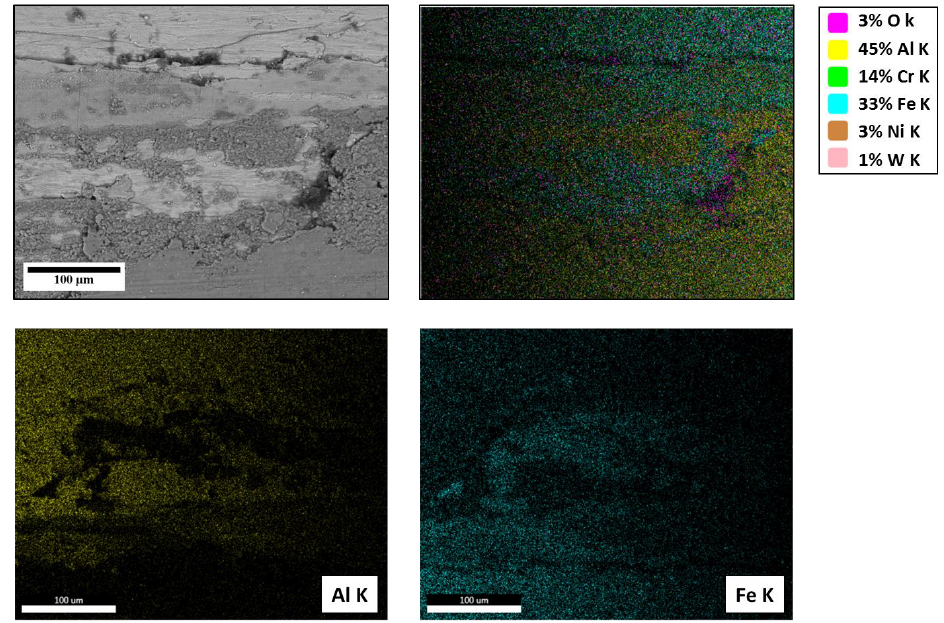
Figure 19. Scanning electron microscope (SEM) mapping of the center zone of friction drilled joint under improvement condition.